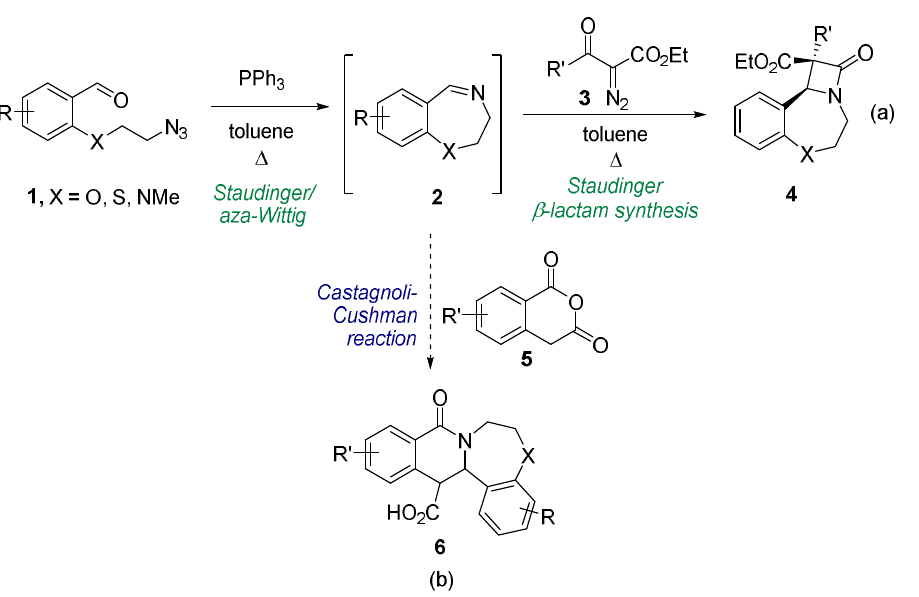
Figure 1. Synthesis of cyclic imines 2 and their involvement in ring-forming processes: ( a ) recently reported and ( b ) investigated in this work.